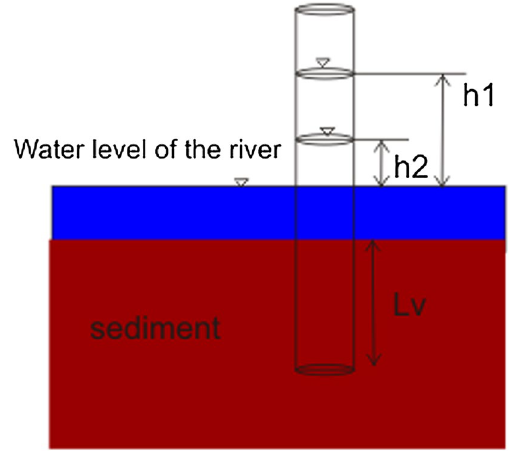
Fig. 3 Schematic diagrams showing an in situ permeameter test to determine streambed K